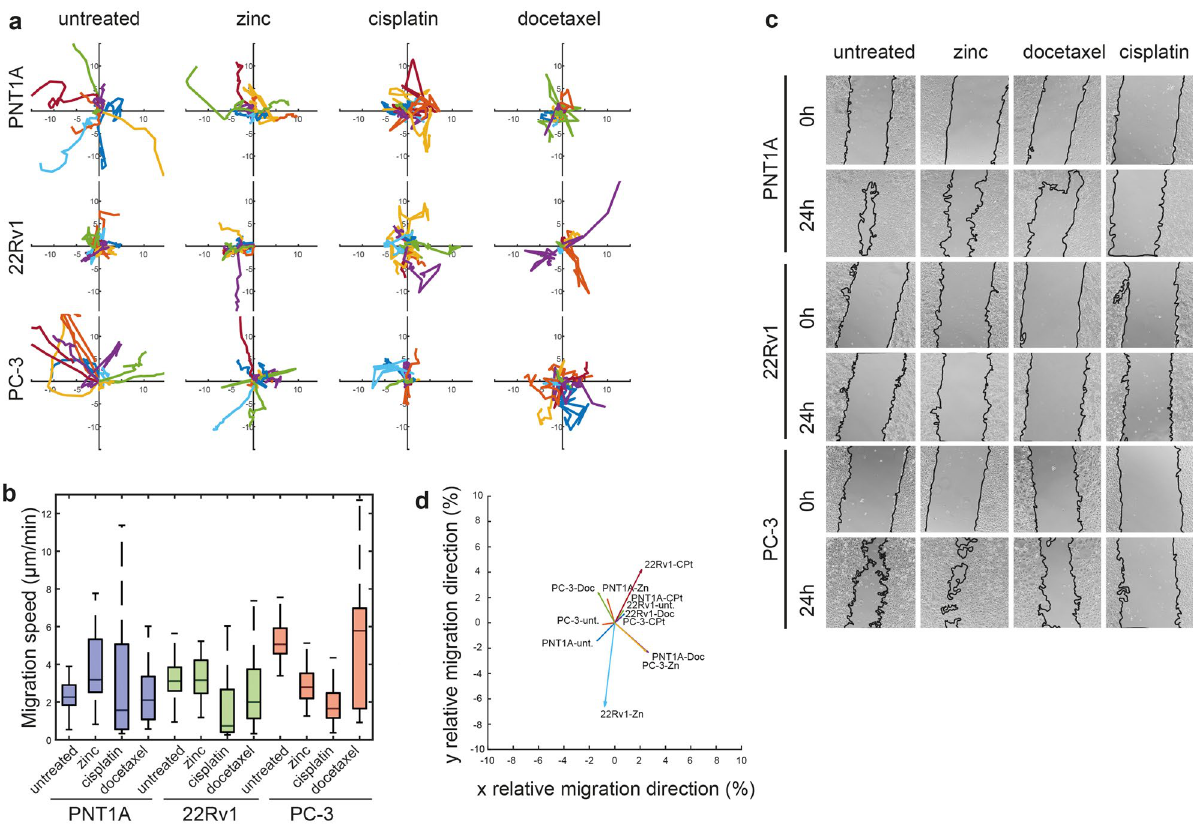
Figure 5. Changes in motility of prostate cancer cells; effect of treatment. ( a ) Rose diagram of cell migration speed obtained by coherence-controlled holographic microscopy and corresponding bar charts, ( b ) Boxes and error bars represent interquartile range and 95% percentile. ( c ) Wound-healing assay in t = 0 and 24 h. ( d ) Summary vector of the movements of all cells after respective treatments divided by migrated path